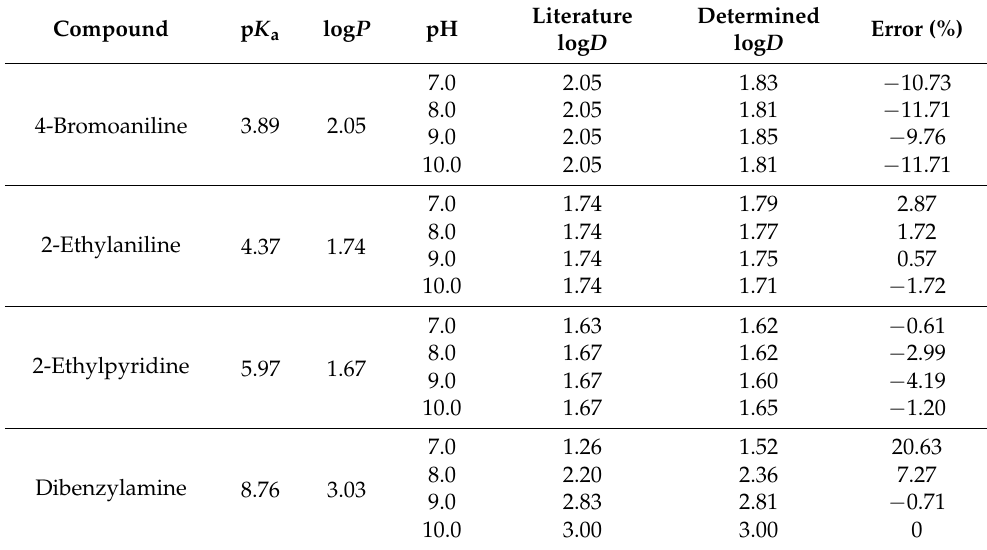
Table 4. External verification of multi-parameter QSRR models at different pH values.